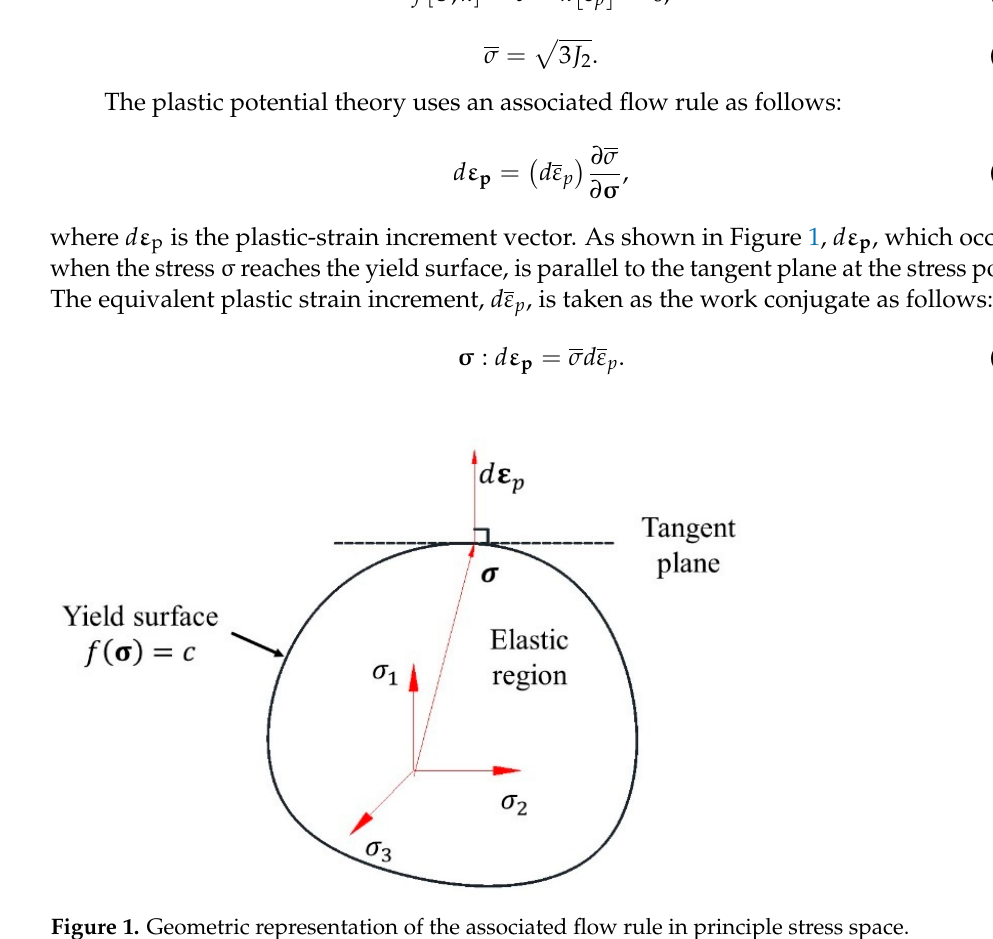
Figure 1. Geometric representation of the associated flow rule in principle stress space.